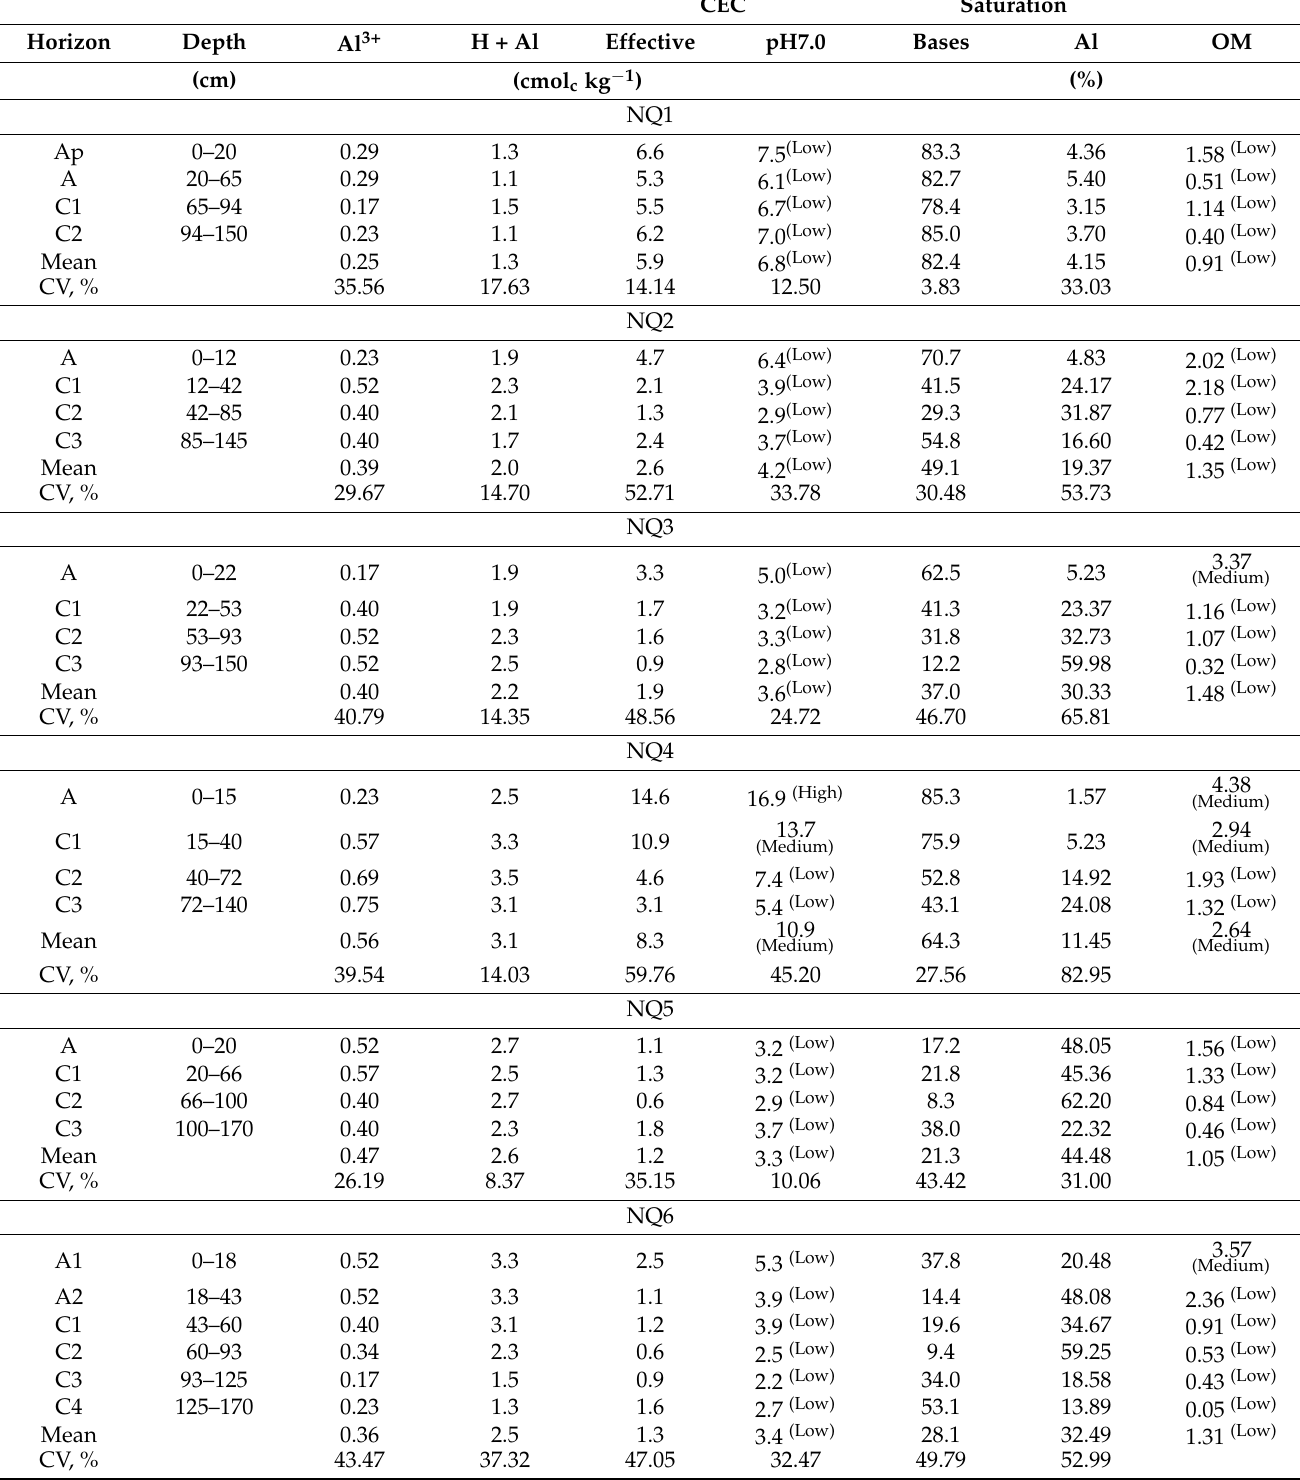
Table 6. Mean values of chemical parameters and interpretation * of Quartzipsamments profiles of the Southwest of Rio Grande do Sul State,